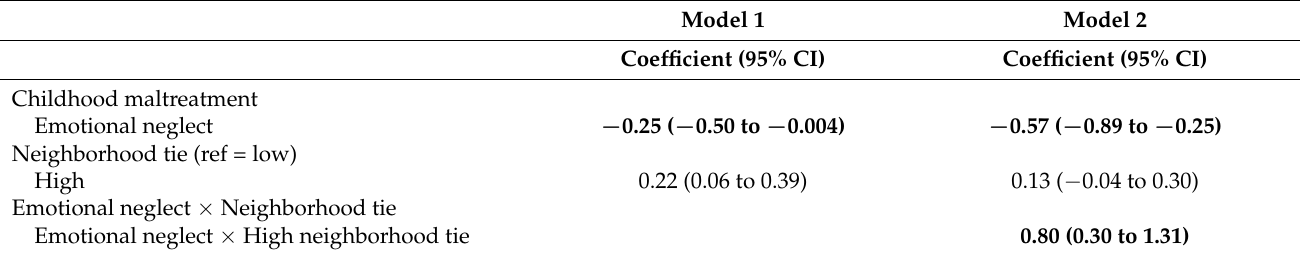
Table 3. Associations of childhood emotional neglect and neighborhood ties with gratitude among Japanese older adults ( n = 524).